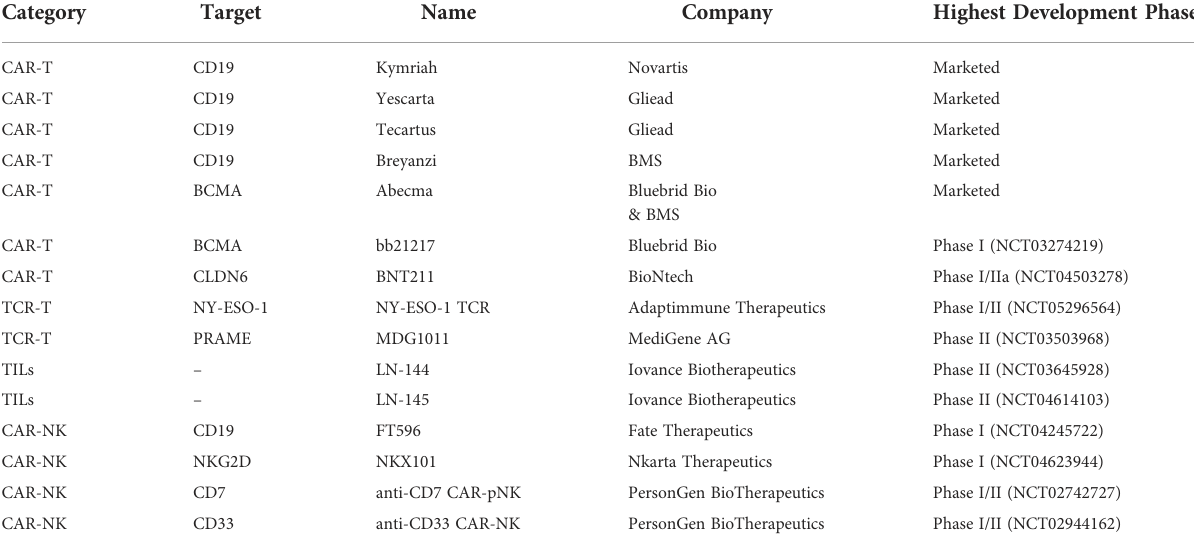
TABLE 3 Summary of major marketed and clinically reported adoptive cell therapy (Up to March 2022).